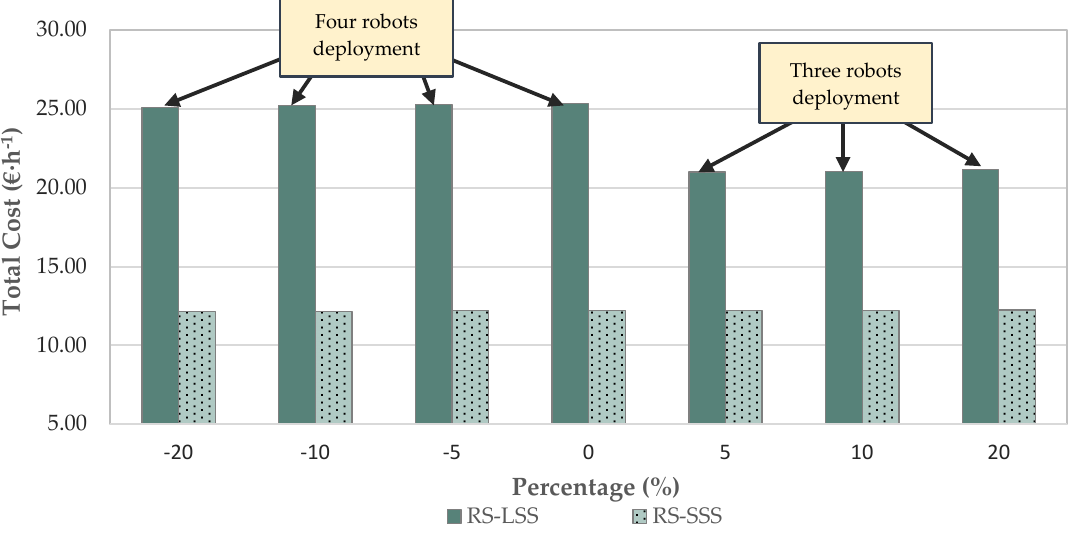
Figure 9. Sensitivity analysis—hourly cost vs. efficiency (RS—Robotic System; CS—Conventional System; SSS—Small-Scale Scenario; LSS—Large-Scale Scenario).